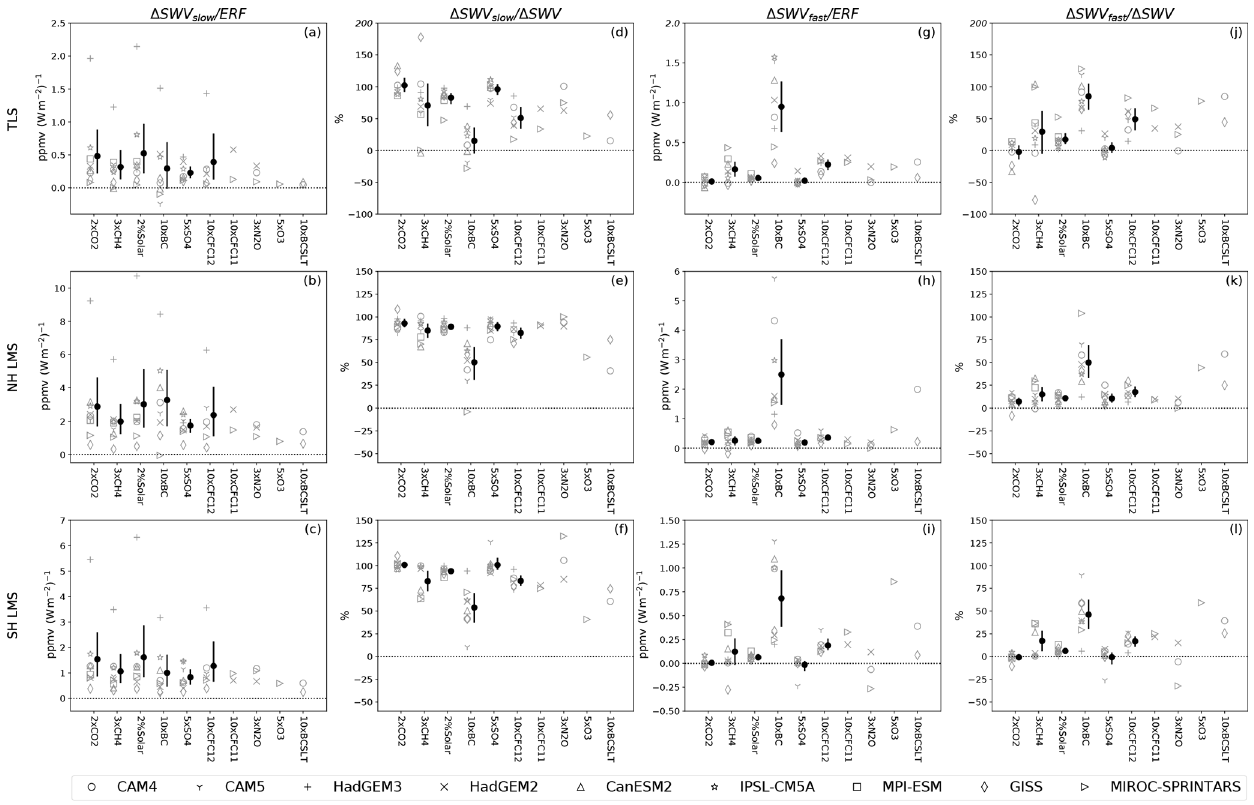
Figure 1. (a–c) Equilibrium (cid:49) SWV slow normalized by ERF (ppmv(Wm − 2 ) − 1 ) in TLS (70hPa, 30 ◦ N–30 ◦ S), NH LMS (200hPa, 50– 90 ◦ N), and SH LMS (200hPa, 50–90 ◦ S). (d–f) Contribution (%) of equilibrium (cid:49) SWV slow to total equilibrium (cid:49) SWV. (g–i) (cid:49) SWV fast normalized by ERF (ppmv(Wm − 2 ) − 1 ). (j–l) Contribution (%) of (cid:49) SWV fast to total equilibrium (cid:49) SWV. The marker shapes indicate results from different models. For perturbations that are performed by more than three models, the solid circles and error bars for each perturbation plotted in solid black are the multi-model mean and 2.5–97.5 percentiles of the model samples. Note that in the second and fourth columns, we took out models with extremely small (cid:49) SWV magnitudes that yield extremely large (cid:49) SWV slow /(cid:49) SWV and (cid:49) SWV fast /(cid:49) SWV